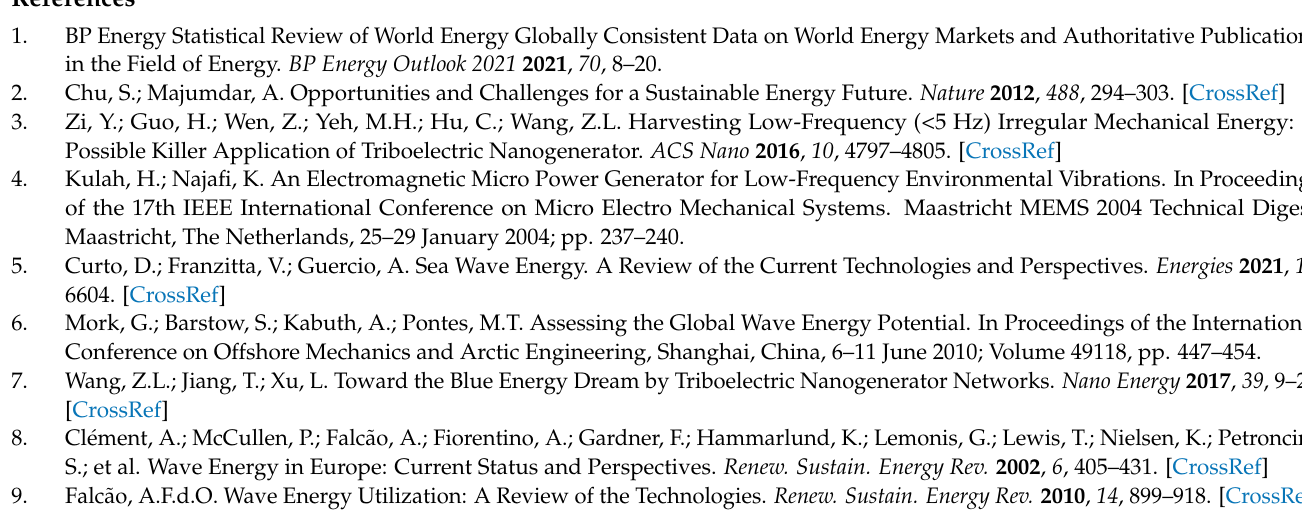
Figure S2: Detailed outputs of the MT-TENG for PTFE balls with various diameter; Figure S3: Detailed outputs of the flat type TENG with 40, 60, 80, 100, 120 balls; Figure S4: Detailed outputs of the MT- TENG with 40, 60, 80, 100, 120 balls; Figure S5: Details of short-circuit current with various frequency and amplitude; Figure S6: Details of transferred charge with various frequency and amplitude; Figure S7: Details of transferred charge with various frequency and amplitude; Figure S8: The output voltage, current and output power for the flat type TENG on the resistance of the load; Figure S9: Photographs of the folding structure of the MT-TENG (a) Two cover plates and intermediate frame. (b) Intermediate frame combined with one cover plate. (c) Intermediate frame combined with two cover plates; Table S1: Some wave energy harvesting TENGs comparison; Video S1: Application of the MT-TENG integrating with life buoy; Video S2: Application of the MT-TENG integrating with floating